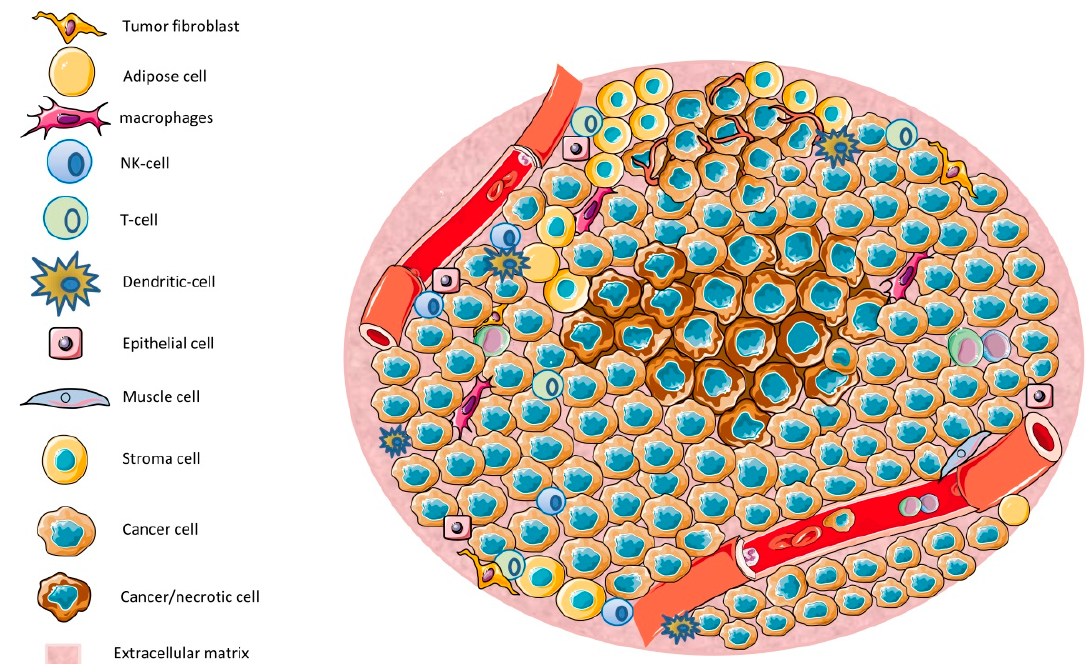
Figure 1. An overview of the tumor microenvironment (TME): The TME is composed by a diverse range of cell types, including tumor cells, immune cells, epithelial cells, and stromal cells. Areas of low nutrients and O 2 result in necrotic regions. The TME controls tumor growth by diverse mechanisms that are further discussed in the text.